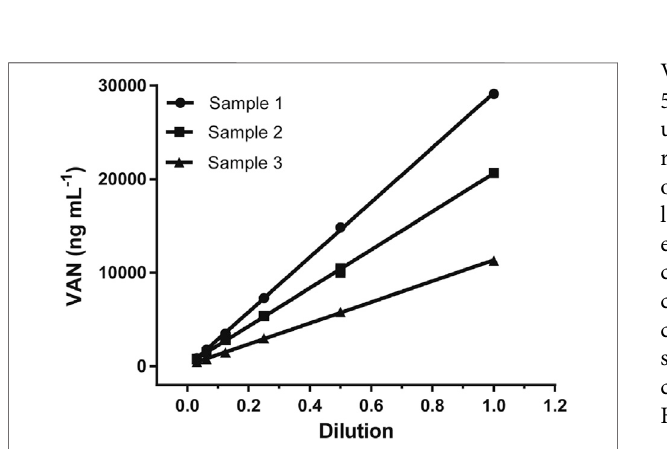
FIGURE3| Thechange trendof fl uorescenceintensitywithin 30 minofincubation. (A) Thechangeofthe fl uorescence peak heights. (B) The changeoftheratioof H T /H C .